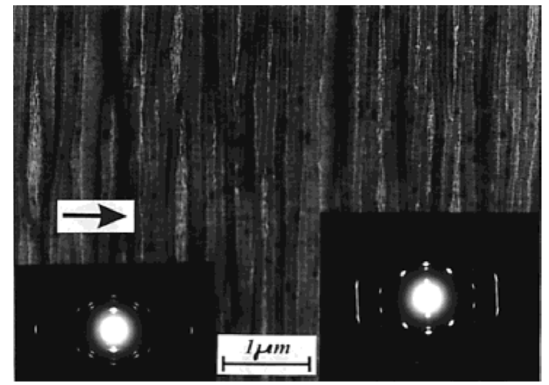
Figure 21. BF electron micrograph and its corresponding electron diffraction patterns (insets) of an oriented iPBu thin film taken during the II-I phase transition. The electron diffraction patterns in the lower left and lower right corners correspond to the form II and form I crystals, respectively. Reproduced with permission from Ref. [90], copyright 2003 American Chemical